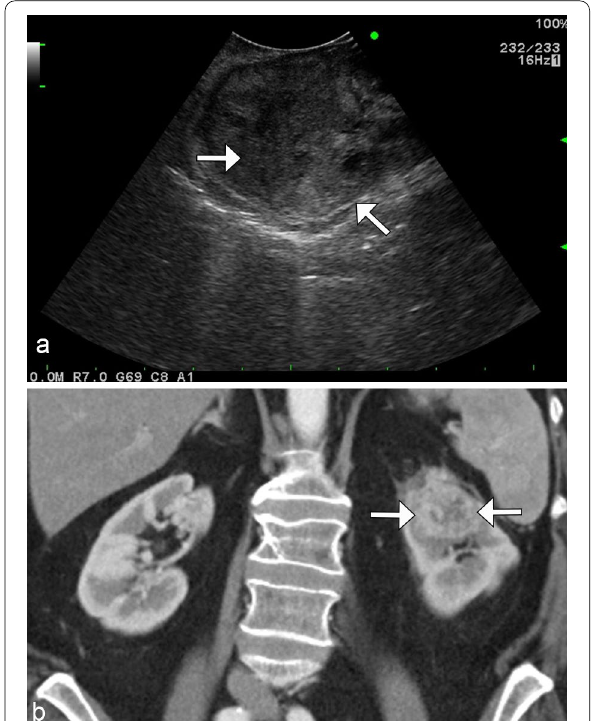
Fig. 16 Clear cell renal cell carcinoma. Sagittal grayscale ultrasound ( a ) demonstrates a heterogeneous right upper pole renal mass (arrows). Coronal contrast CT ( b ) demonstrates enhancement of the renal lesion (arrows). Biopsy confirmed renal cell carcinoma. Note the increased vascularity and heterogeneity relative to what would typically be seen in a solitary renal lymphomatous lesion